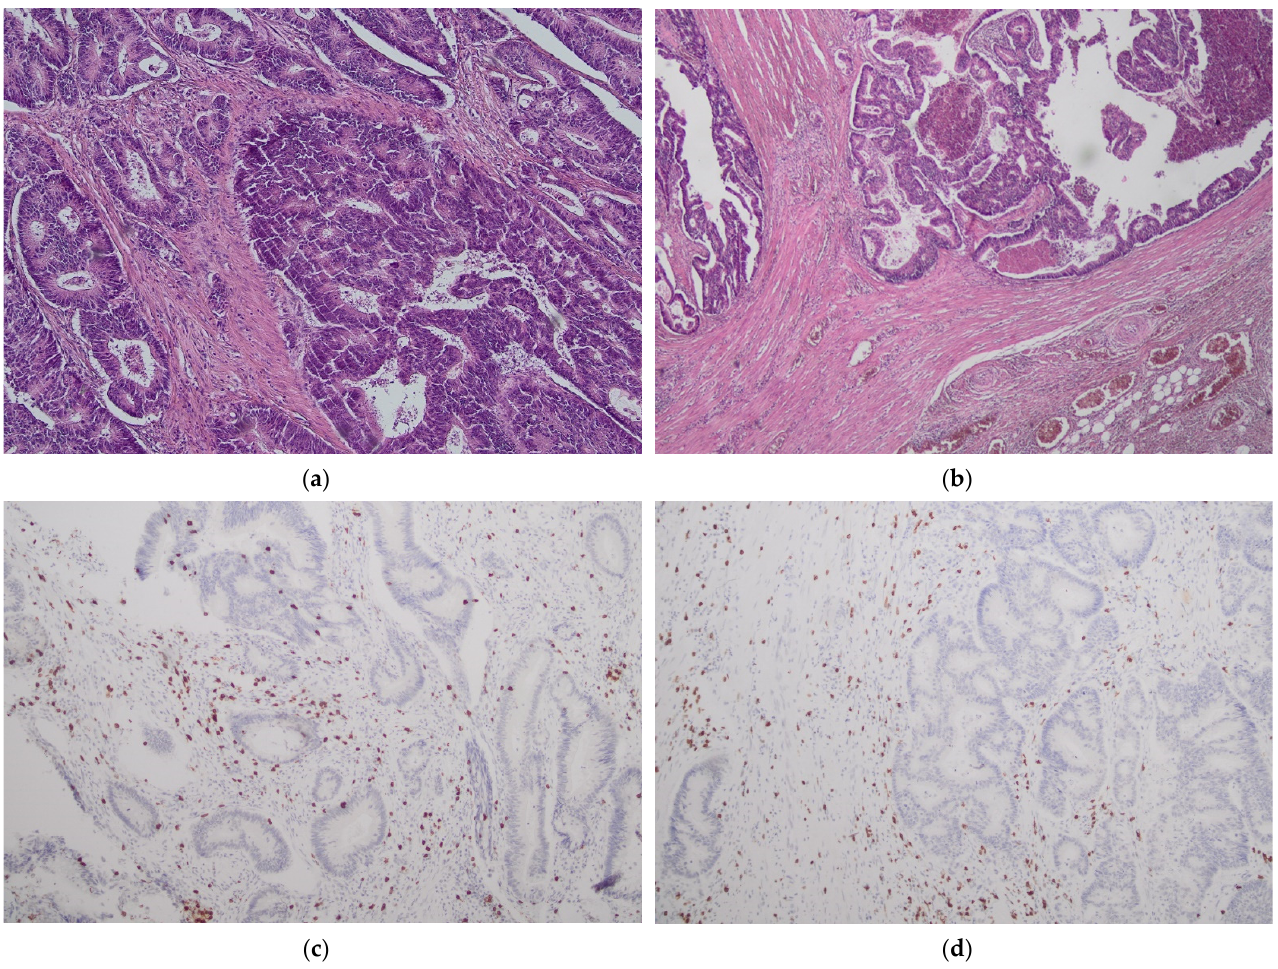
Figure 1. No/minimal lymphocyte infiltrates in tumor center (CT) ( a , c ) and tumor margin (IM) ( b , d ). H&E staining ×40 ( a ); H&E staining ×100 ( b ) ; CD3 staining ×100 ( c , d ).